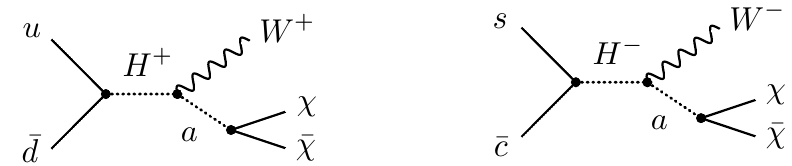
Figure 11 . Examples of diagrams that lead to a W + E T; miss signature through the exchange of a charged Higgs H (cid:6) and a lighter pseudoscalar a in the THDM plus pseudoscalar